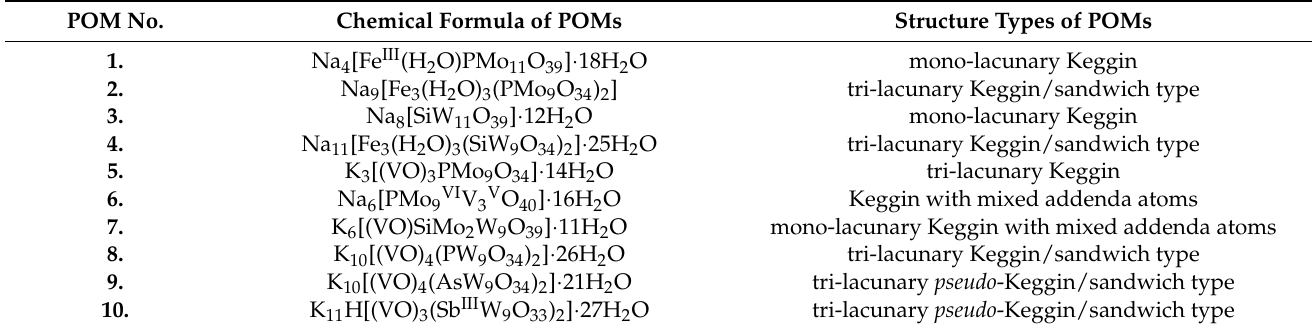
Table 1. The structure of all the synthesized